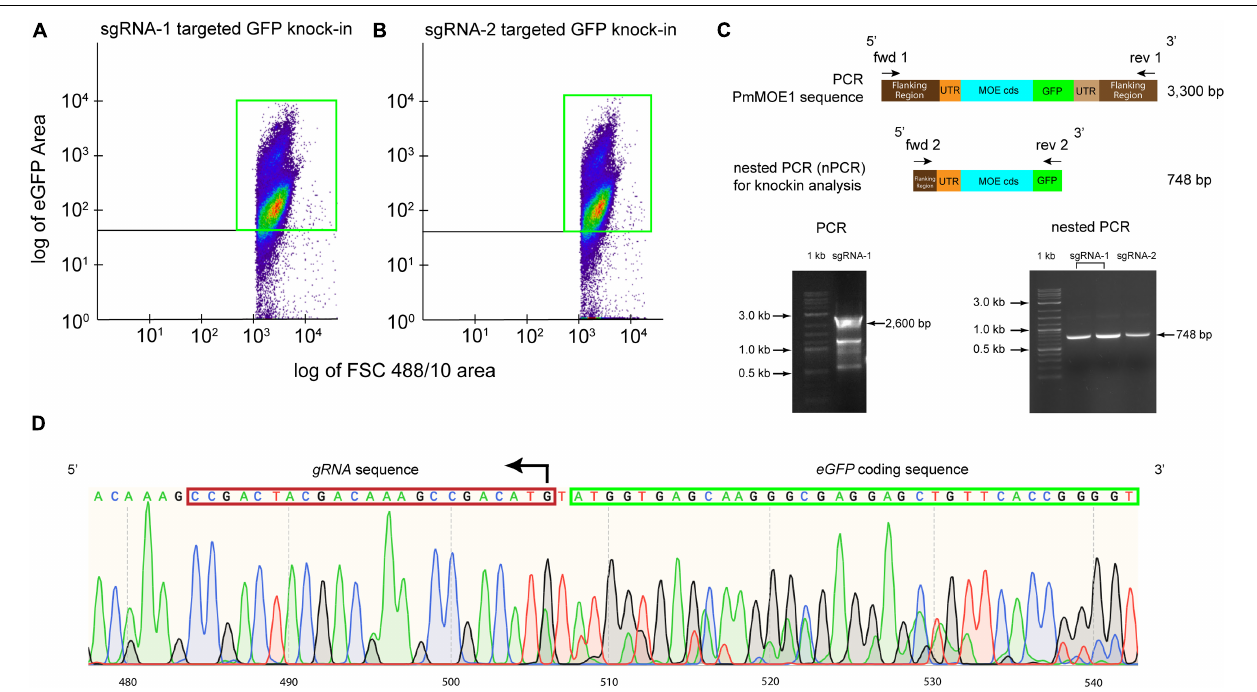
FIGURE 4 | Sorting P. marinus GFP-positive cells for endogenous PmMOE1 C-terminus GFP tagging analysis. (A) Scattered plot showing 81% GFP-positive cells indicated with a green box in the experiment where cells transfected with sgRNA-1-Cas9. (B) Scattered plot showing 87% GFP-positive cells indicated with a green box in the experiment where cells transfected with sgRNA-1-Cas9. (C) The PCR intended to amplify the knock-in (expected sized 3,300 bp) using Fwd 1 and Rev 1 primers resulting in the amplification of the wildtype 2,600 bp amplicon (left panel). This PCR product was used as a template in the nested PCR (nPCR) to confirm the GFP knock-in using Fwd 2 and Rev 2 primers, which yielded the expected 748 bp amplicon (right panel), 1 kb Plus DNA Ladder (New England Biolabs, Ipswich, MA, United States). (D) Sequencing results of the nPCR product from the sgRNA-2 targeted GFP knock-in